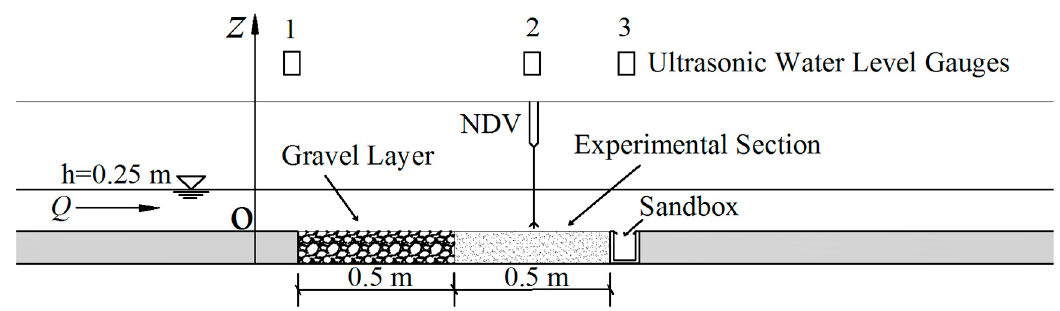
Figure 1. Experimental